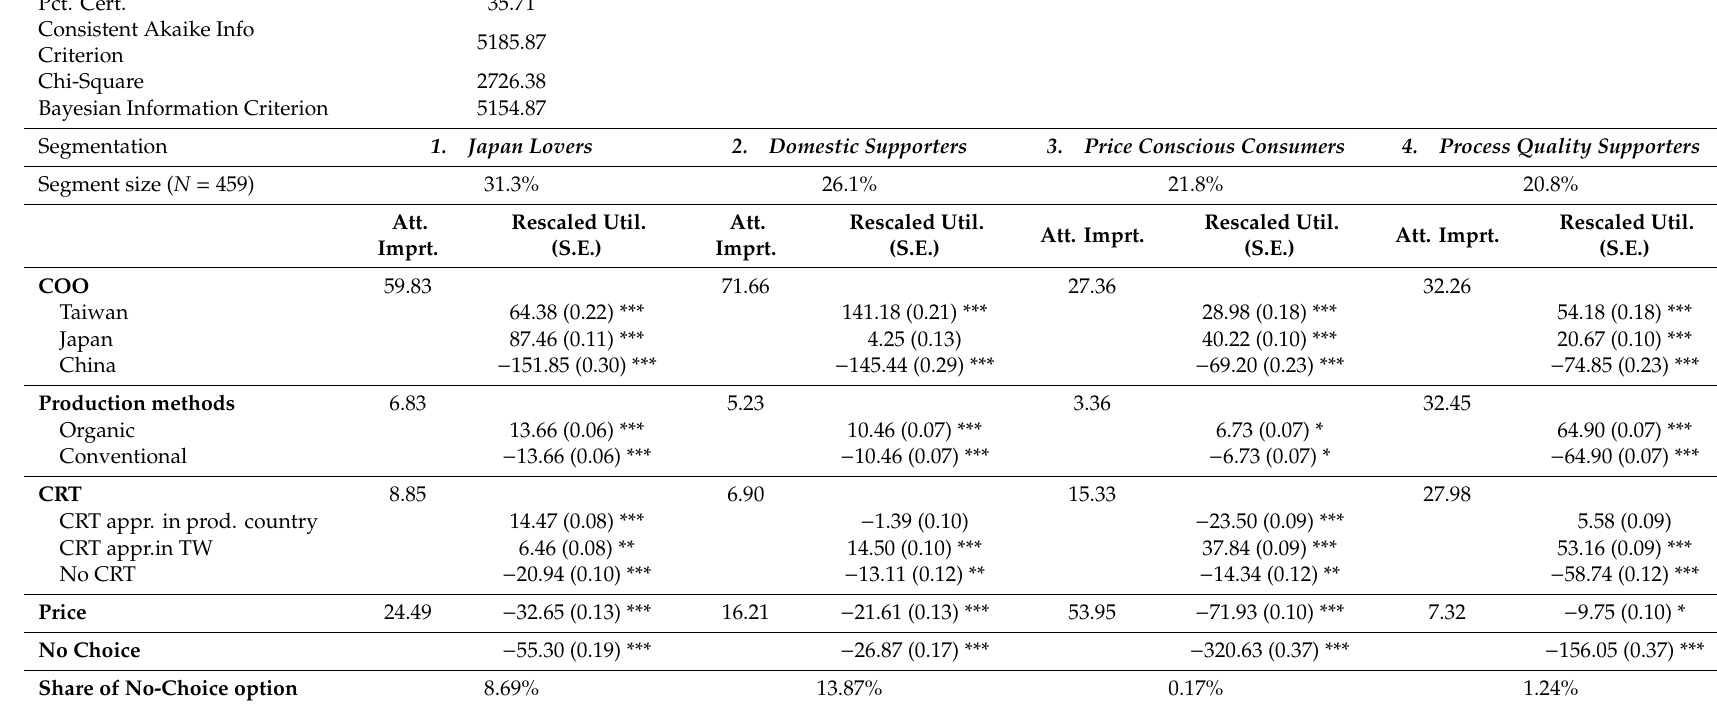
Table 5. Latent class analysis of DCE